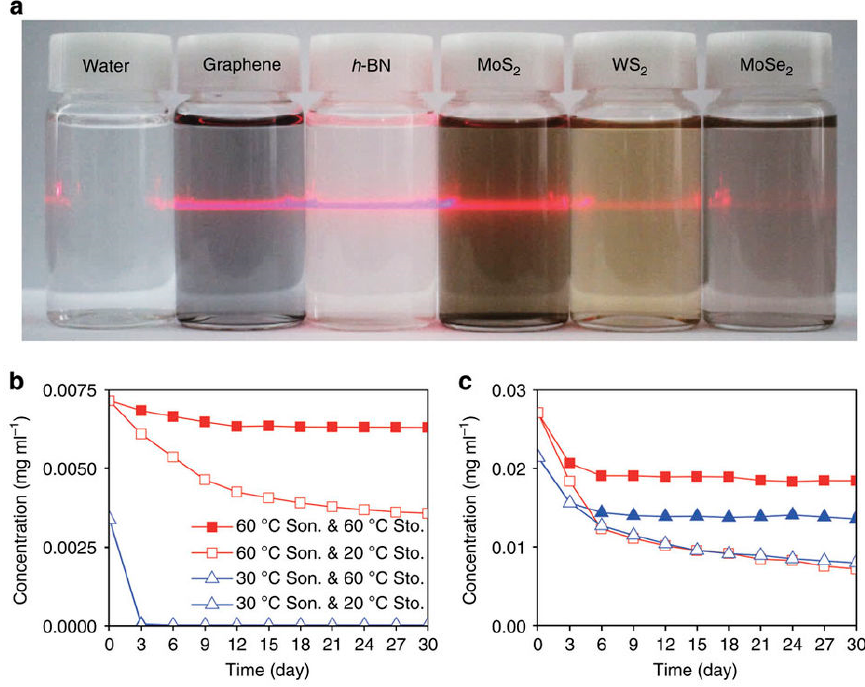
Figure 22. Temperature-dependent solution stabilities of the 2D materials in water. ( a ) Photographs of solutions of five 2D materials dispersed in deionized water for one month. The laser light across the solution bottles provides visual assistance because some suspended materials such as h-BN are not clearly visible. The long-term solution stabilities of ( b ) graphene, ( c ) h-BN sonicated at the high (60 °C) and low (30 °C) temperature and stored at high (60 °C) and low (20 °C) temperatures. In ( b ), two types of triangles almost overlap because of fast precipitation. In ( b , c ), squares and triangles denote high and low temperature sonication and solid and blank denote high and low temperature storage, respectively. Reproduced from [115]. Copyright Nature Publishing Group, 2015.